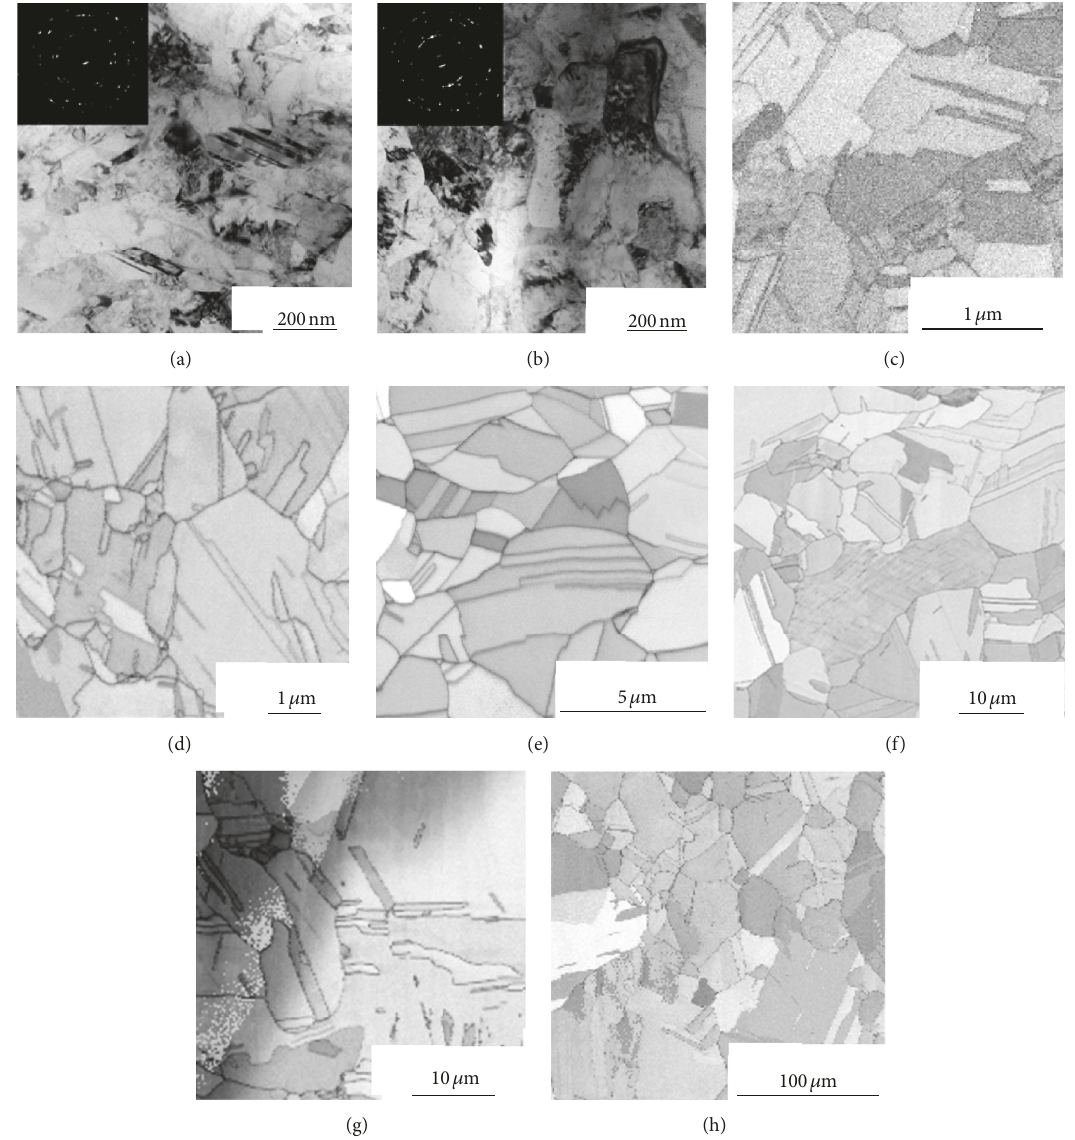
Figure 5: Microstructure after ECAP/cold-rolling and final annealing of (a) sample 8, (b) sample 7, (c) sample 6, (d) sample 5, (e) sample 4, (f) sample 3, (g) sample 2, and (h) sample